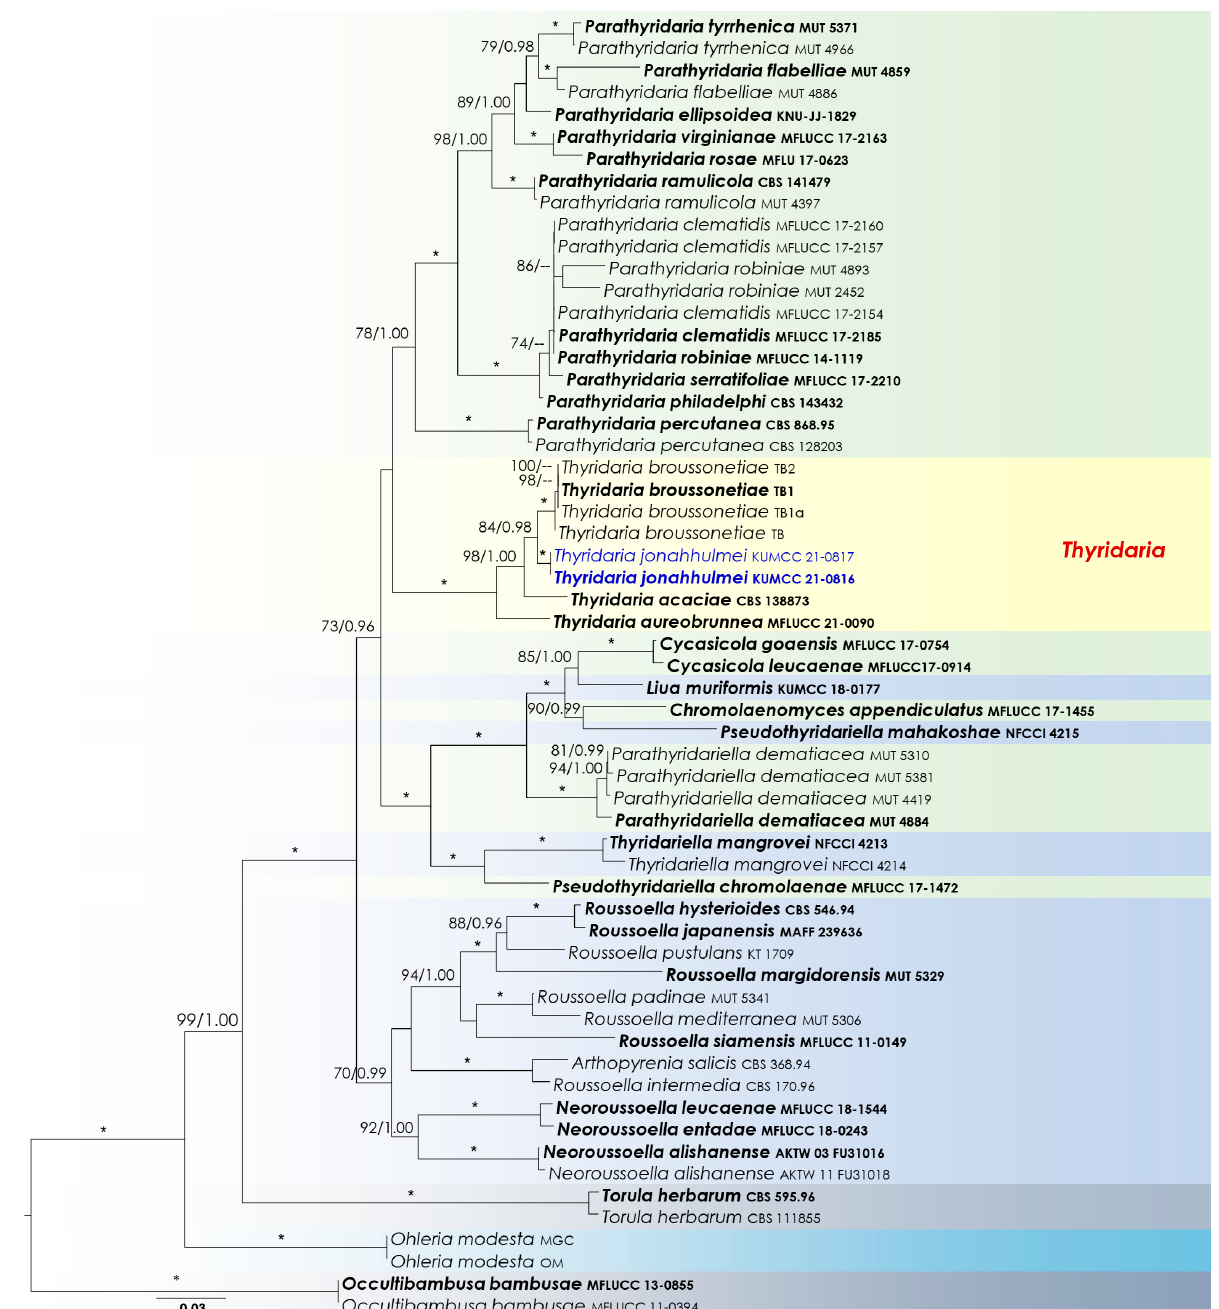
Figure 3. Phylogram generated from RAxML based on a concatenated sequence dataset of partial SSU, LSU, ITS, tef 1, and rpb 2 DNA for Thyridariaceae . Bootstrap values equal to or greater than 70% for ML (MLB) and Bayesian posterior probabilities (BYPP) ≥ 0.95 are shown at each node (as MLB/BYPP). An asterisk (*) represents branches with MLB = 100% and BYPP = 1.00. The new isolates are show in in blue.